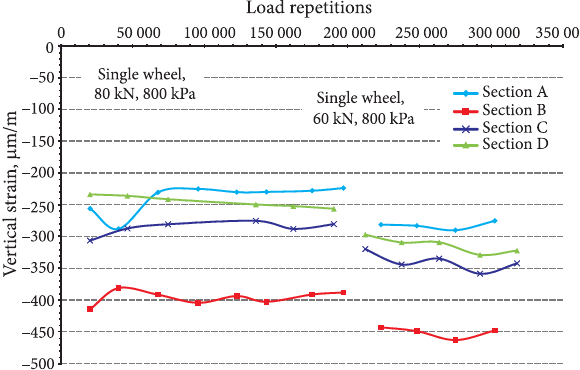
Fig. 5. Development of vertical strain at the top of subgrade (ε ze )